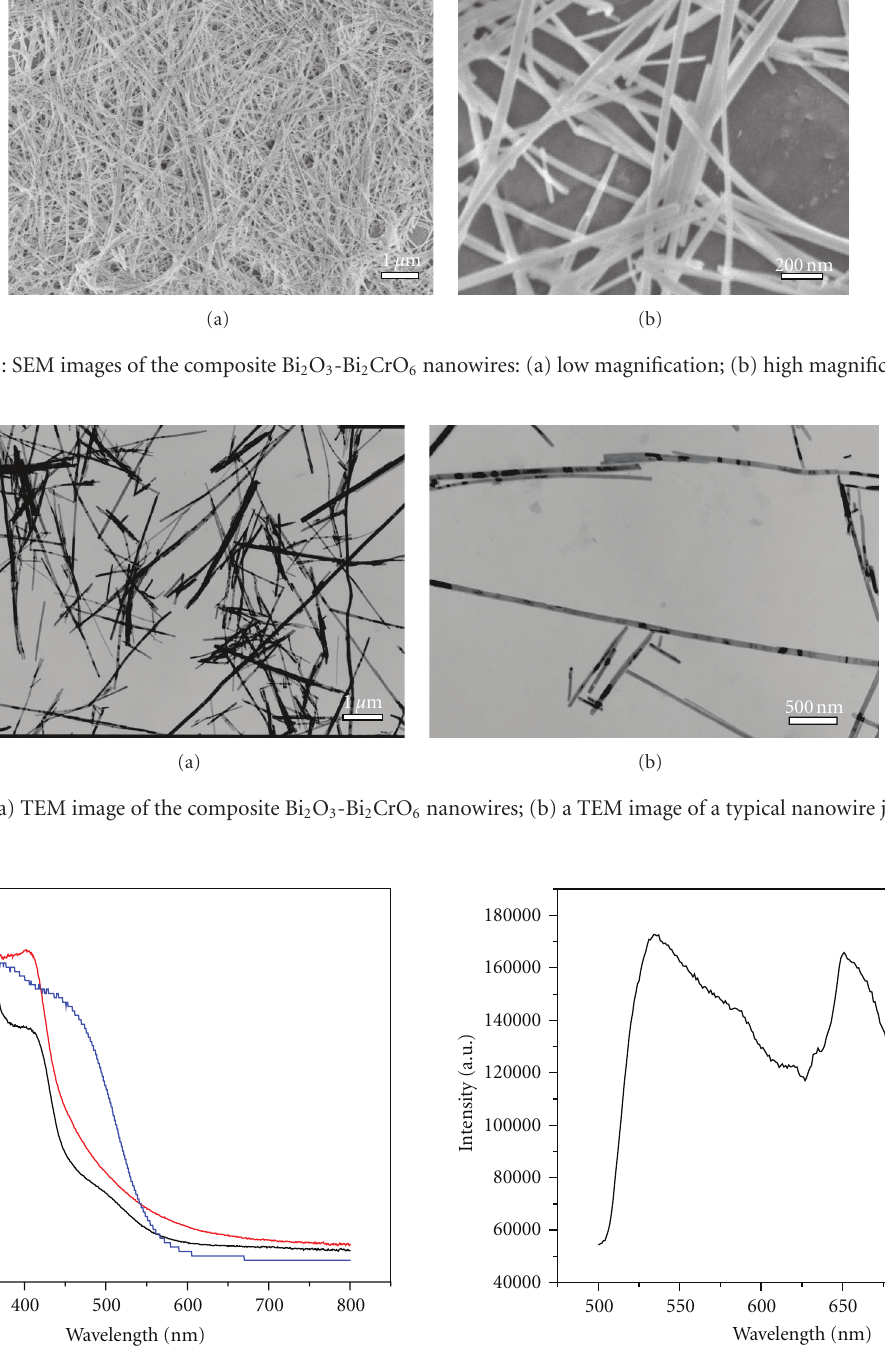
Figure 5: The PL spectrum of the composite Bi 2 O 3 -Bi 2 CrO 6 nanowires. in 440 nm to 540 nm is strongest. The PL spectrum of the sample is presented in Figure 5. Two peaks, 535 and 651 nm in the PL spectrum can be seen, which meant two recombined semiconductors. Both of them are in visible light region; one is attributed to Bi 2 O 3 , and the other is due to Bi 2 CrO 6 . The excitation wavelength was set at 430